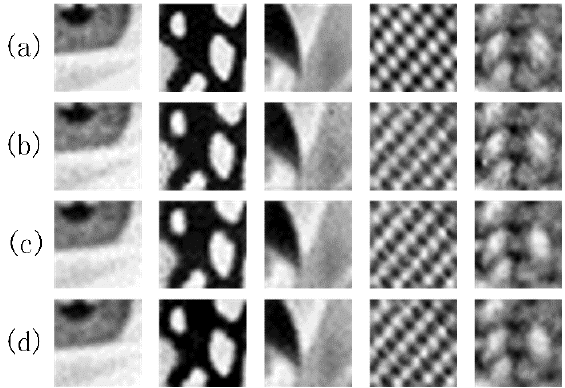
Figure 12. DPAP imaging results using different channel denoising autoencoders at a measurement rate of 0.2, from top to bottom are ( a ) original images; ( b ) reconstructions without denoising auto- encoders; ( c ) a single-channel denoising autoencoder; ( d ) a three-channel denoising autoencoder.